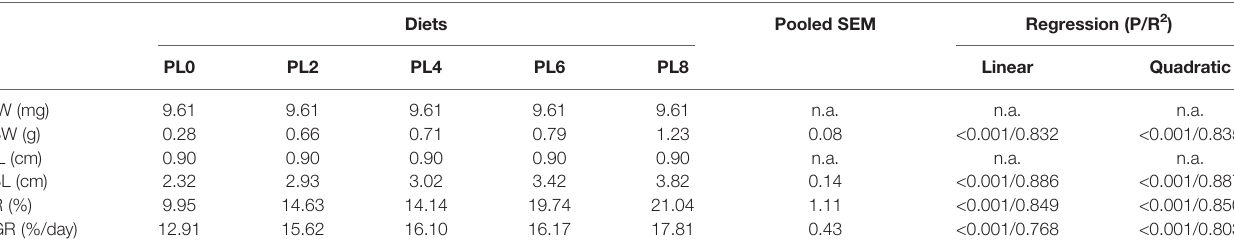
TABLE 3 | Growth performance of largemouth bass larvae fed the experimental diets for 28